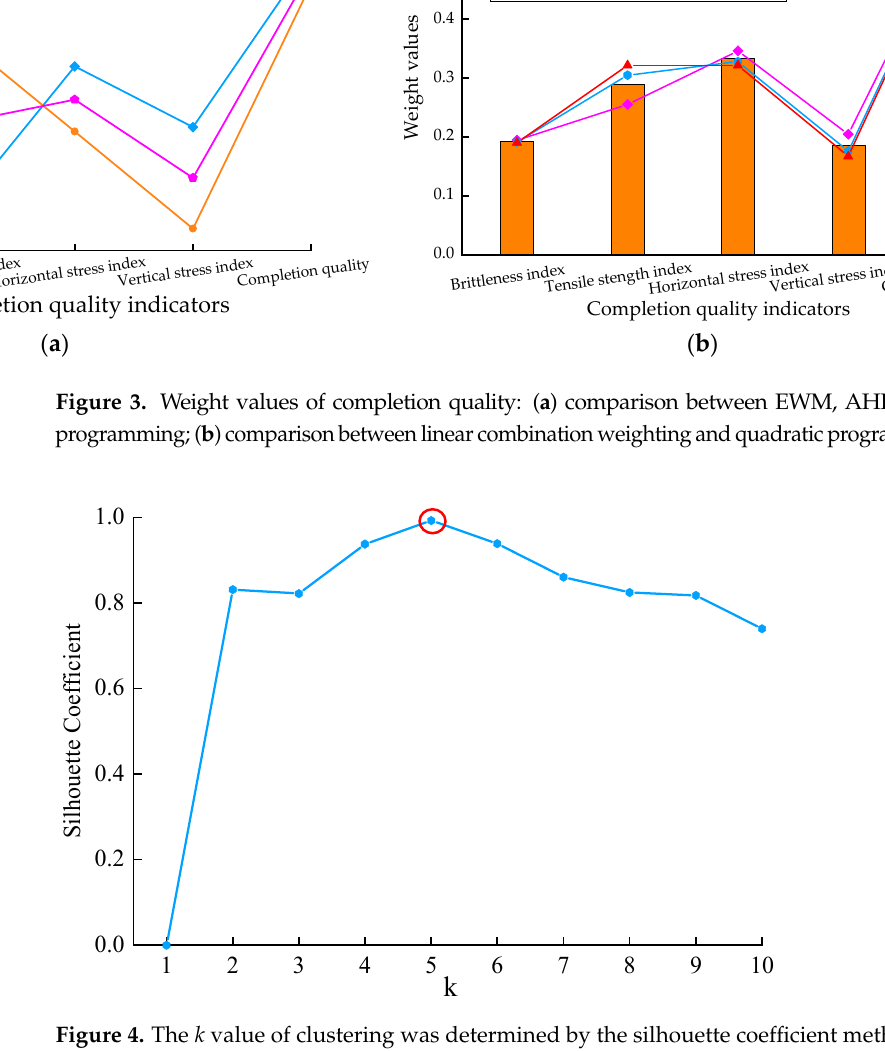
Figure 4. The k value of clustering was determined by the silhouette coefficient method.